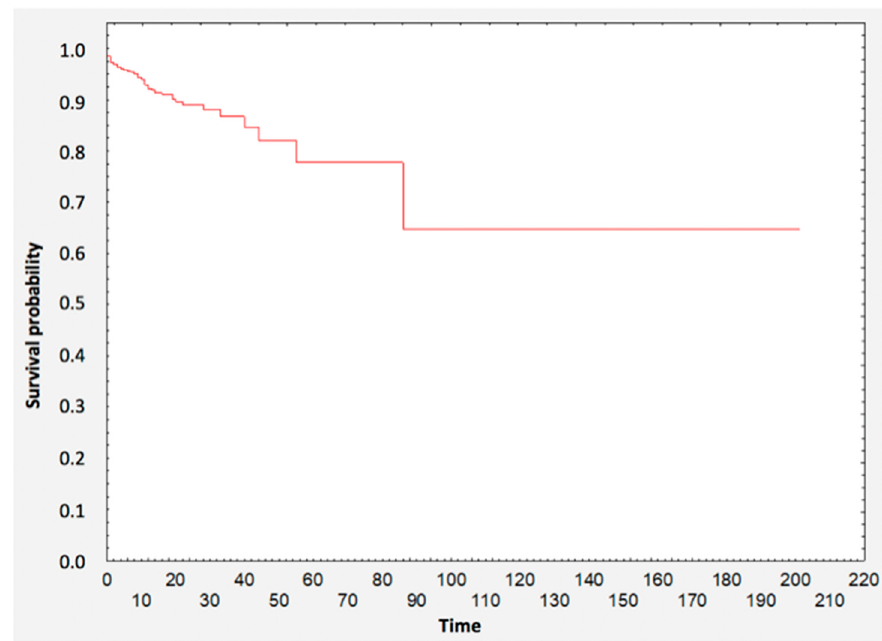
Figure 1. Analysis of survival for the entire group.